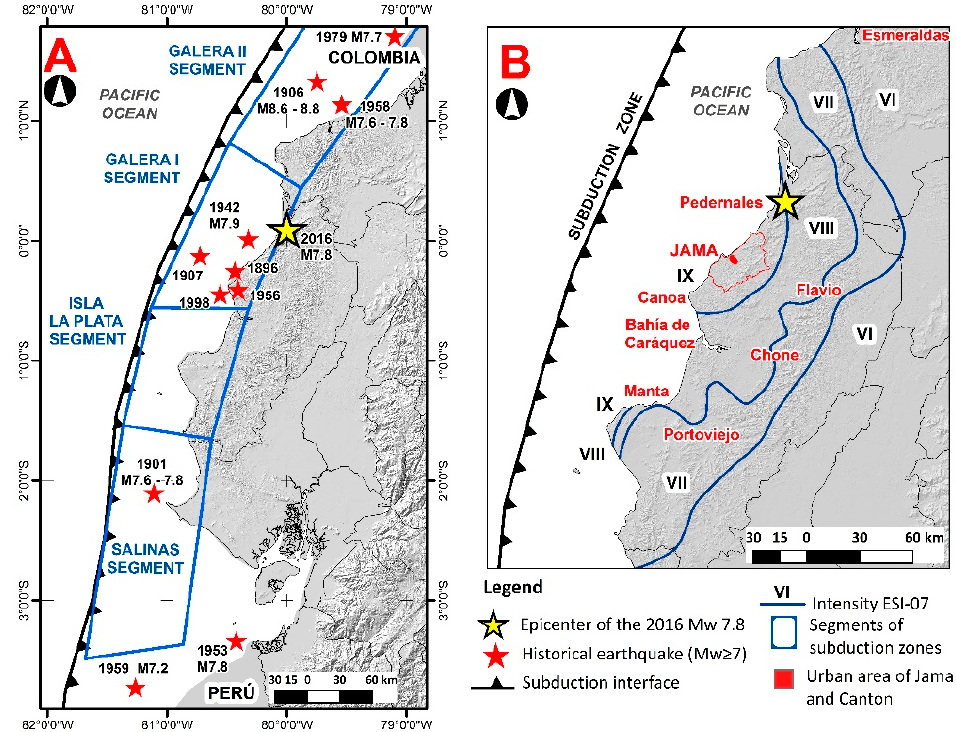
Table 1. List of the parameters of the tectonic segments along the coast of Ecuador, as modified from the IOC [57].